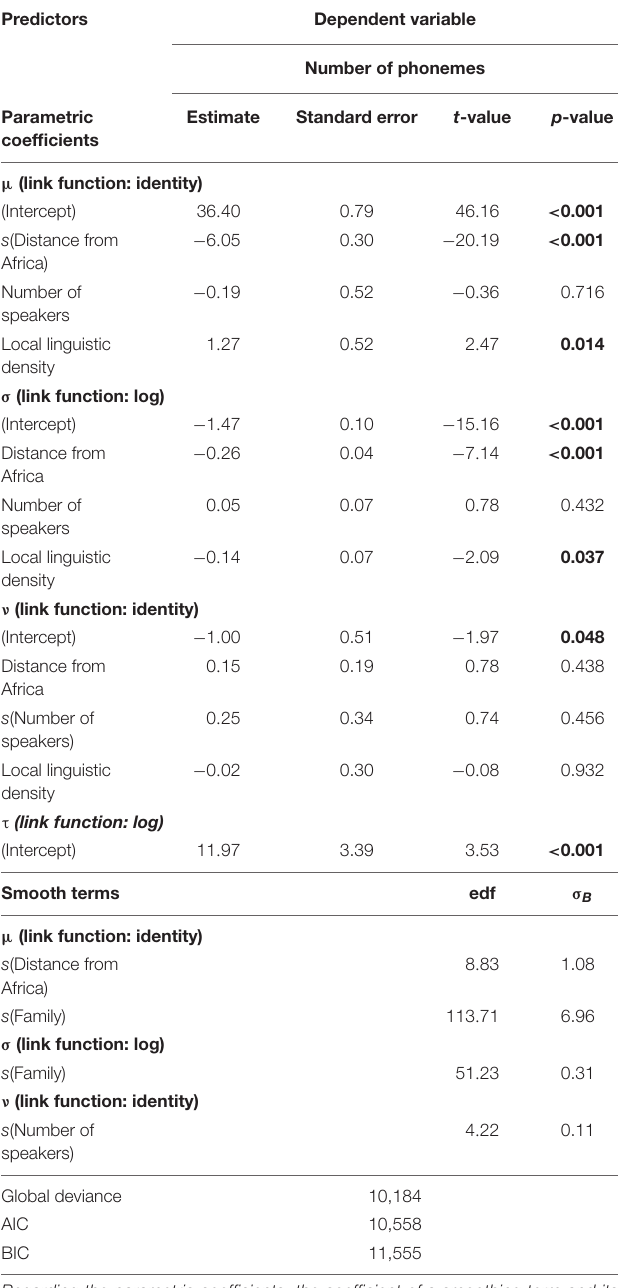
TABLE 6 | Output of a GAMLSS with (i) Box-Cox t distribution, (ii) µ , σ , and ν modeled with either linear predictors or penalized P-splines smooth functions of these predictors, and a penalized random effect smoother for the categorical variable Family when necessary, (iii) τ modeled as intercept only.